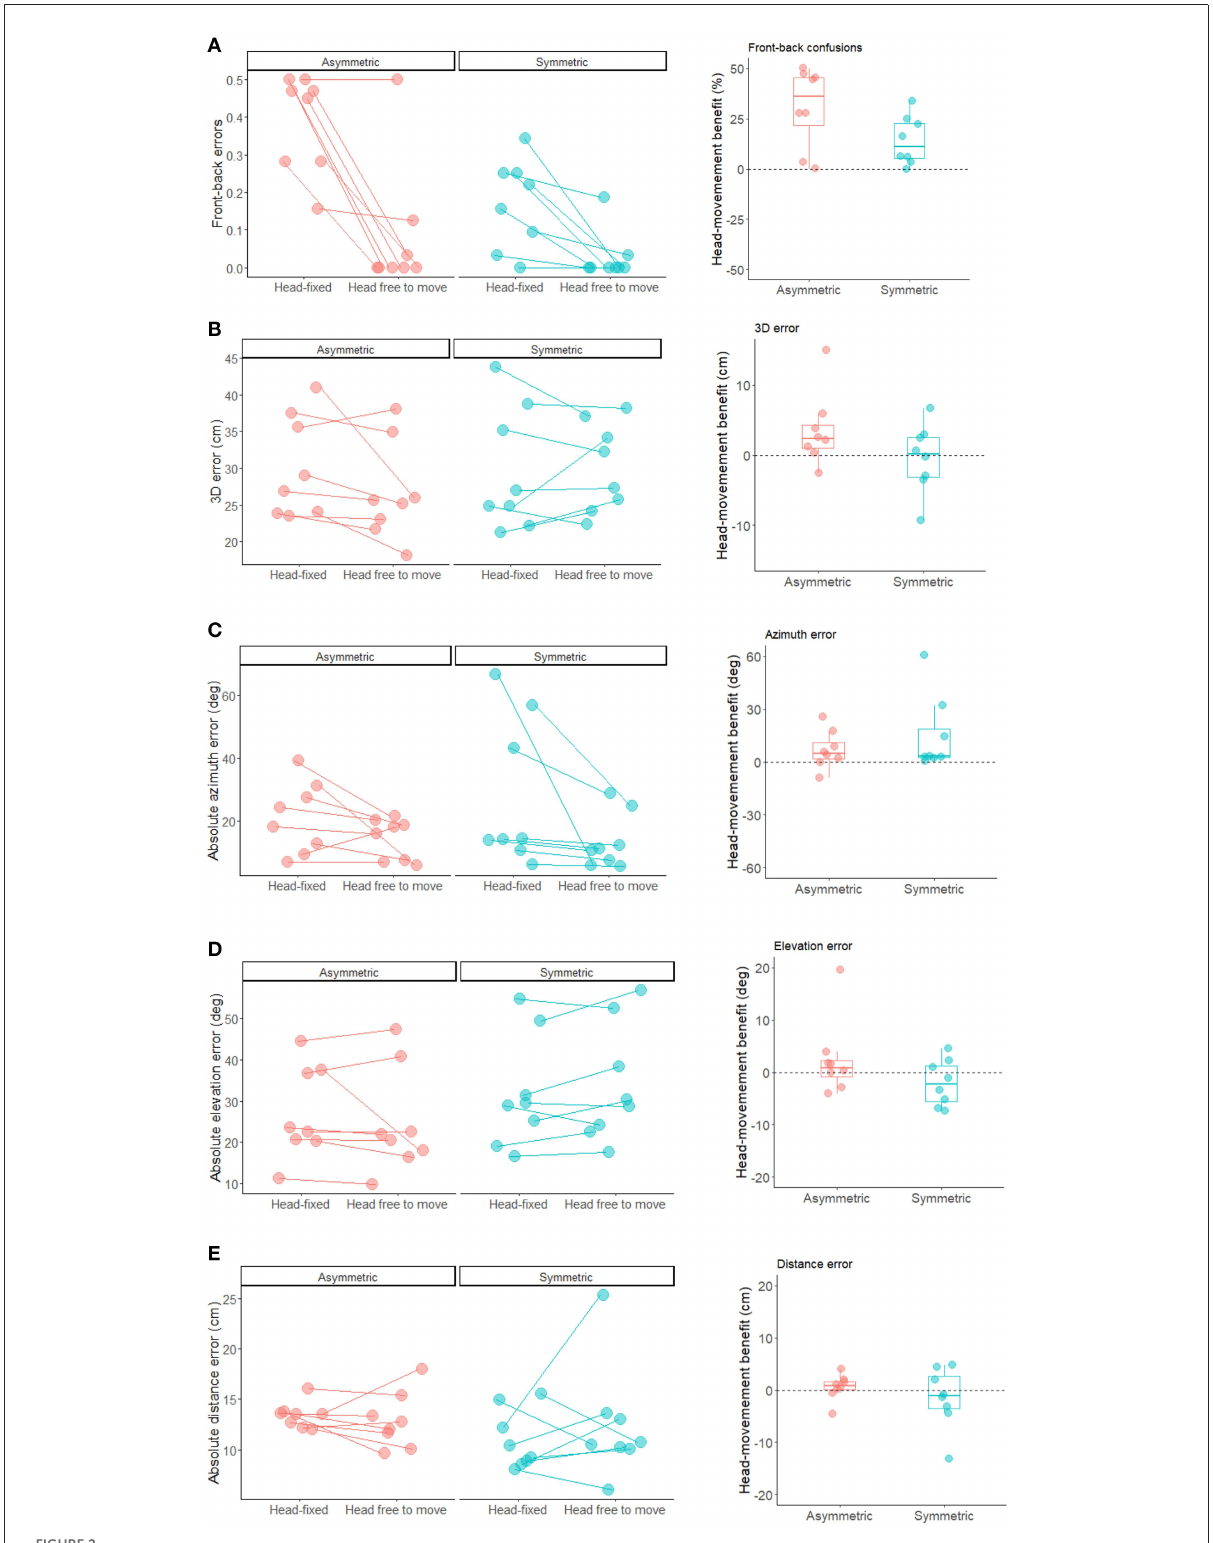
FIGURE2 Individual performance (left plots) and head-movement benefit (right plots) for each participant in the front-back task (A) as well as the 3D sound localization task (B) 3D error; (C) azimuth error; (D) elevation error; (E) distance error. The head-movement benefit was calculated as the difference between errors in the head-free vs. head-fixed listening condition. Positive values indicate better performance when the head was free to